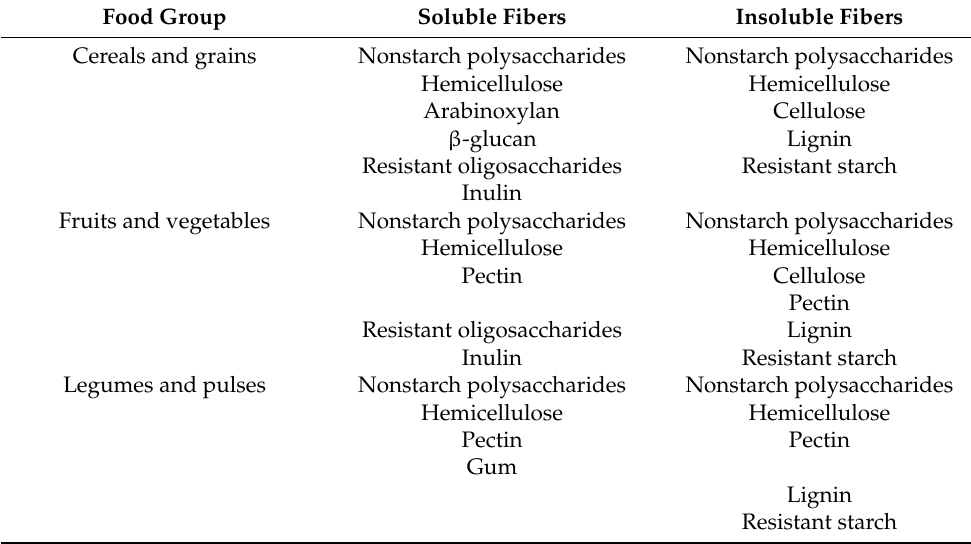
Table 1. Main food groups and fiber varieties according to